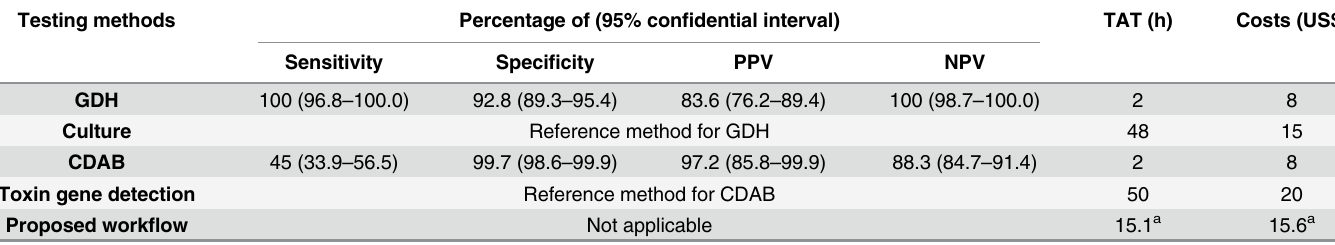
Table 1. Comparison of the diagnostic methods for C . difficile infections in this